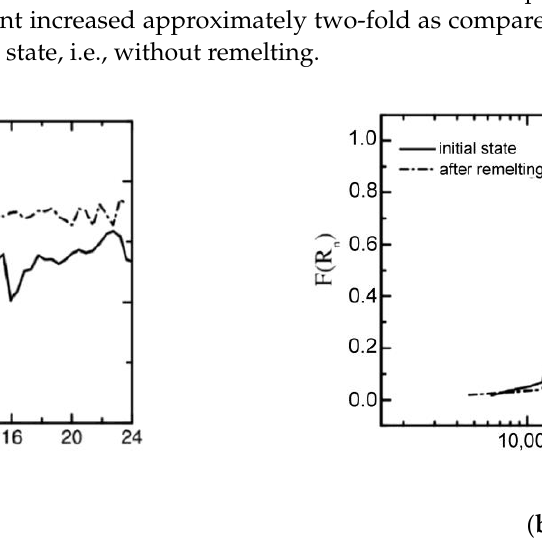
Figure 9. ( a ) Noise resistance obtained for remelted and non-remelted samples; ( b ) cumulative probability plot of R n .